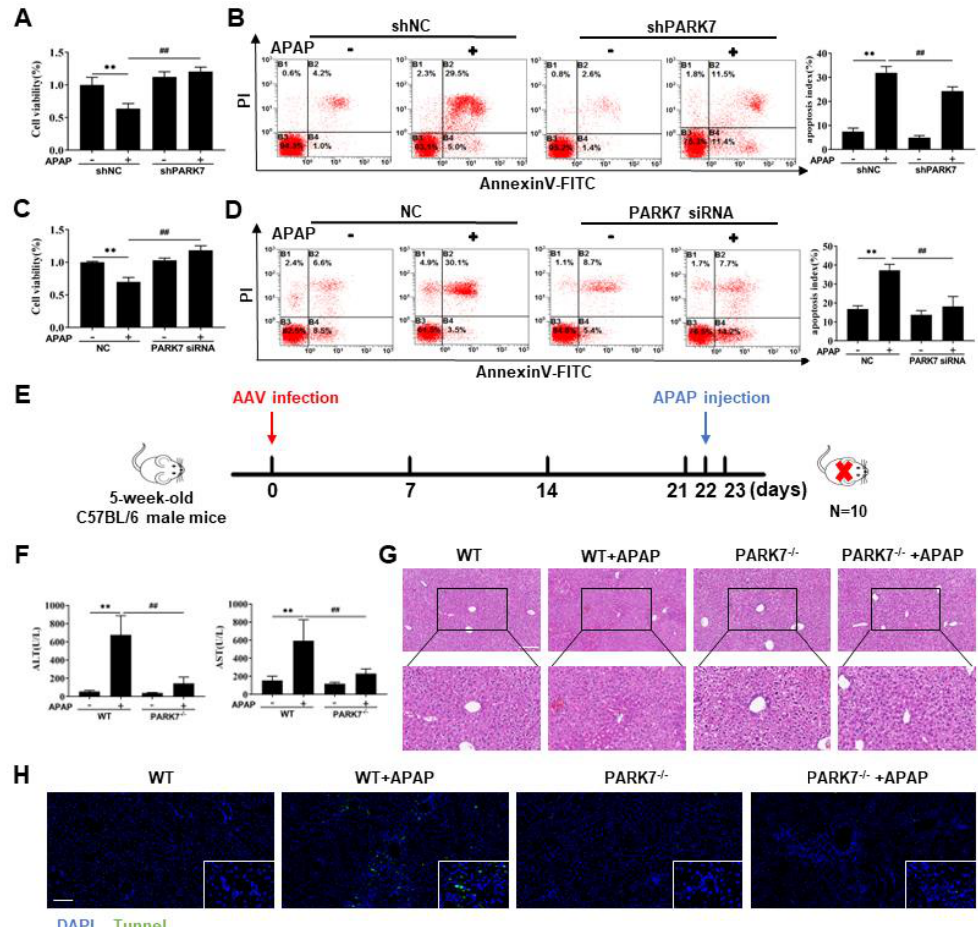
Figure 3. Silencing PARK7 protected against APAP-induced liver injury. ( A ) L02 cell viability under APAP intervention with or without PARK7 silencing, N = 6. ( B ) Apoptosis of L02 cells treated with APAP with or without PARK7 silencing, N = 3. ** p < 0.01 vs. shNC group, ## p < 0.01 vs. shNC+APAP group. ( C ) Changes in the viability of AML12 cells with or without PARK7 silencing, N = 6. ( D ) Apoptosis of AML12 cells with or without PARK7 silencing, N = 3. ** p < 0.01 vs. NC group, ## p < 0.01 vs. NC+APAP group. ( E ) Schematic representation of drug intervention in mice. ( F ) Changes in serum ALT and AST in mice after PARK7 knockdown, N = 10. ** p < 0.01 vs. WT group, ## p < 0.01 vs. WT+APAP group. ( G ) Changes in HE staining after PARK7 knockdown, N = 3. ( H ) TUNEL staining changes after PARK7 knockdown, N = 3.